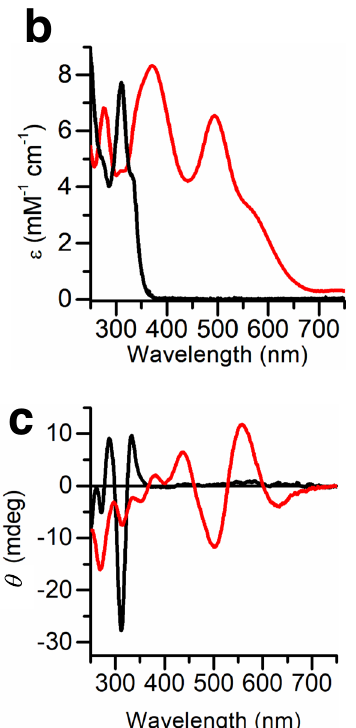
Fig. 4 |FeMETPsc1 spectroscopiccharacterization.a UV-VistitrationofMETPsc1 with Fe 2+ , spectra at increasing iron concentration are reported from violet to green.Absorbancesat311nmarereportedintheinset(blacksquares)and fi ttedby a1:1bindingisotherm(reddashedline).Mohr ’ ssalt(36mM)aliquotswereaddedto a30 μ MMETPsc1solutionina20mMHEPESbuffer(pH7)and1mMTCEP. b,c UV-